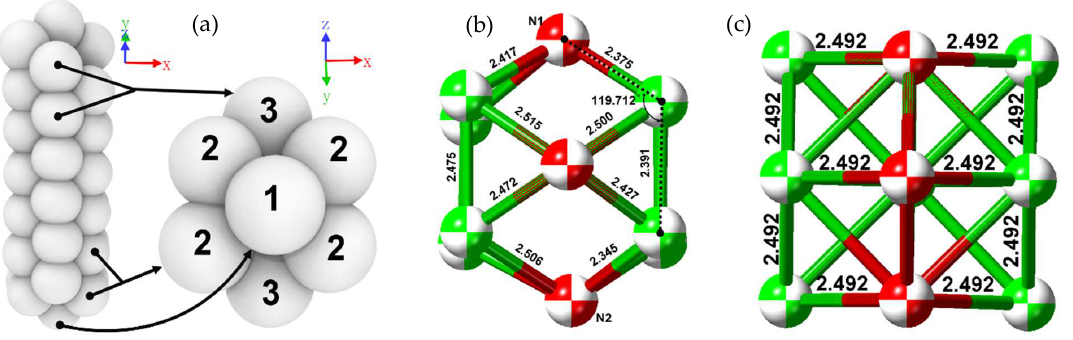
Figure 11. Columnar defect and standard FCC structure with the specific parameter. ( a ) is a columnar defect, ( b , c ) show the atomic arrangement of the defect and the perfect FCC, respectively. The red atom is the atom leaving the lattice point.